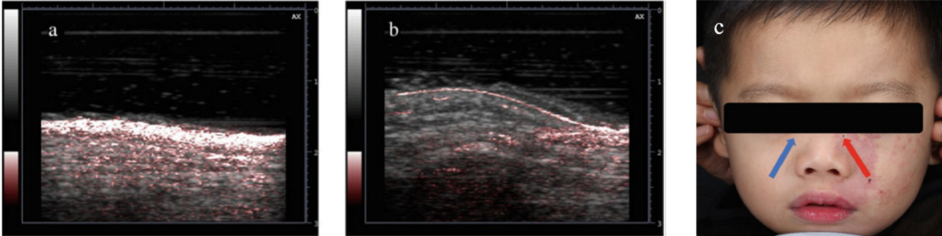
Figure 15. Typical PA / US overlay image of ( a ) PWS region (ROI) and ( b ) control region (HR). ( c ) Photograph of a PWS patient with imaging assisting marks. Reprinted with permission from Ref.